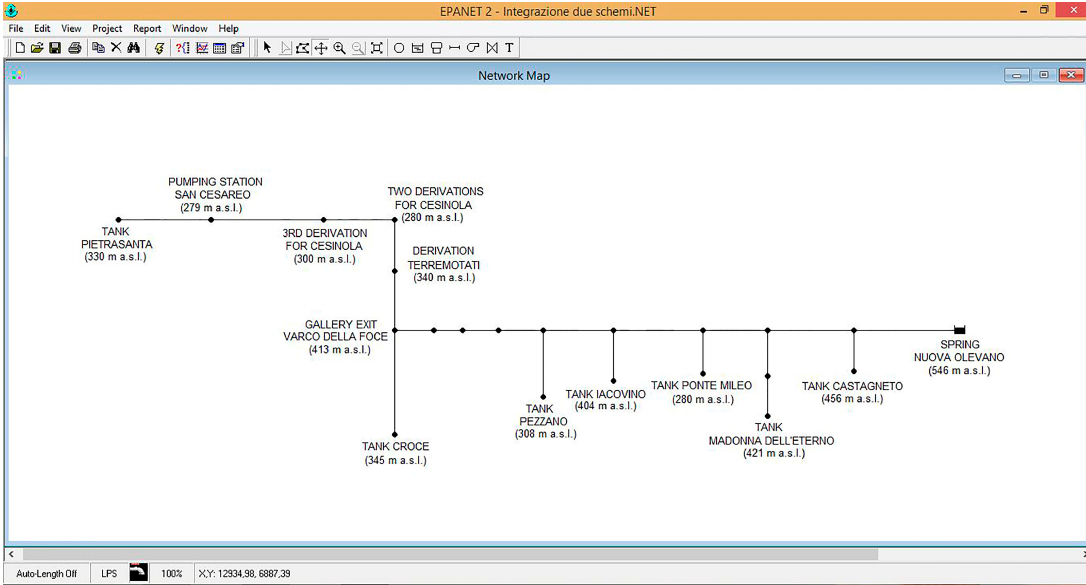
Figure 1. The “New Aqueduct” implemented in the EPANET environment.